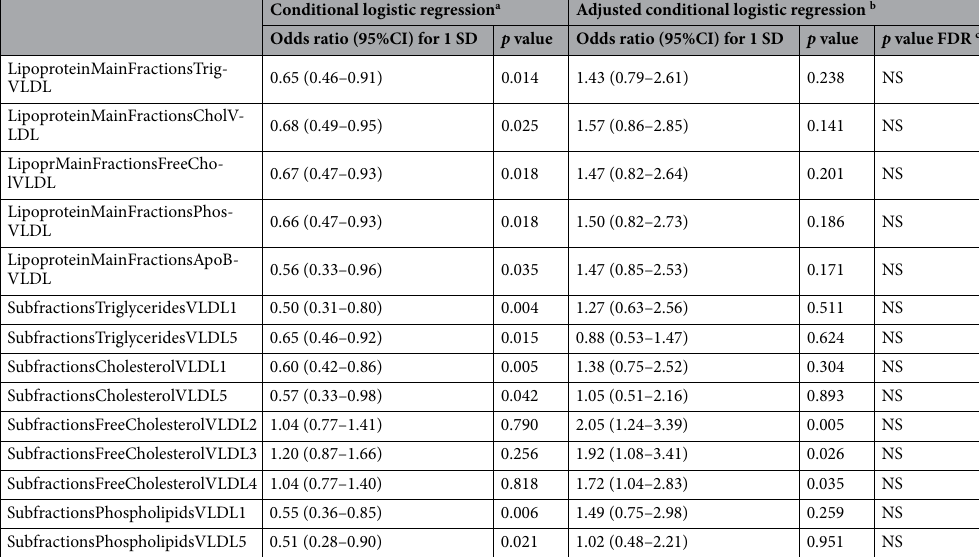
Table 3. Association between lipoprotein subfractions concentration and high-MBD cases, compared to low-MBD BC cases, in the 87 sets (EPIC Florence, low- vs high-MBD BC case–case study). a Odds ratios per standard deviation (SD) increase in metabolite concentration conditioned on age at cohort entry (± 5 years), type of mammographic examination (analogical/digital; negative/diagnostic) and year of mammographic examination (before/after 2000). Single lipoprotein subfractions separately added to the regression model. b Odds ratios per standard deviation (SD) increase in metabolite concentration conditioned on age at cohort entry (± 5 years), type of mammographic examination (analogical/digital; negative/diagnostic) and year of mammographic examination (before/after 2000) and adjusted for age at diagnosis, number of full-term pregnancies, breastfeeding (yes/no), menopausal status, ER status, body mass index. Single lipoprotein subfractions separately added to the regression model. c p values adjusted for false discovery rate (FDR) at α = 0.05 with Benjamini–Hochberg